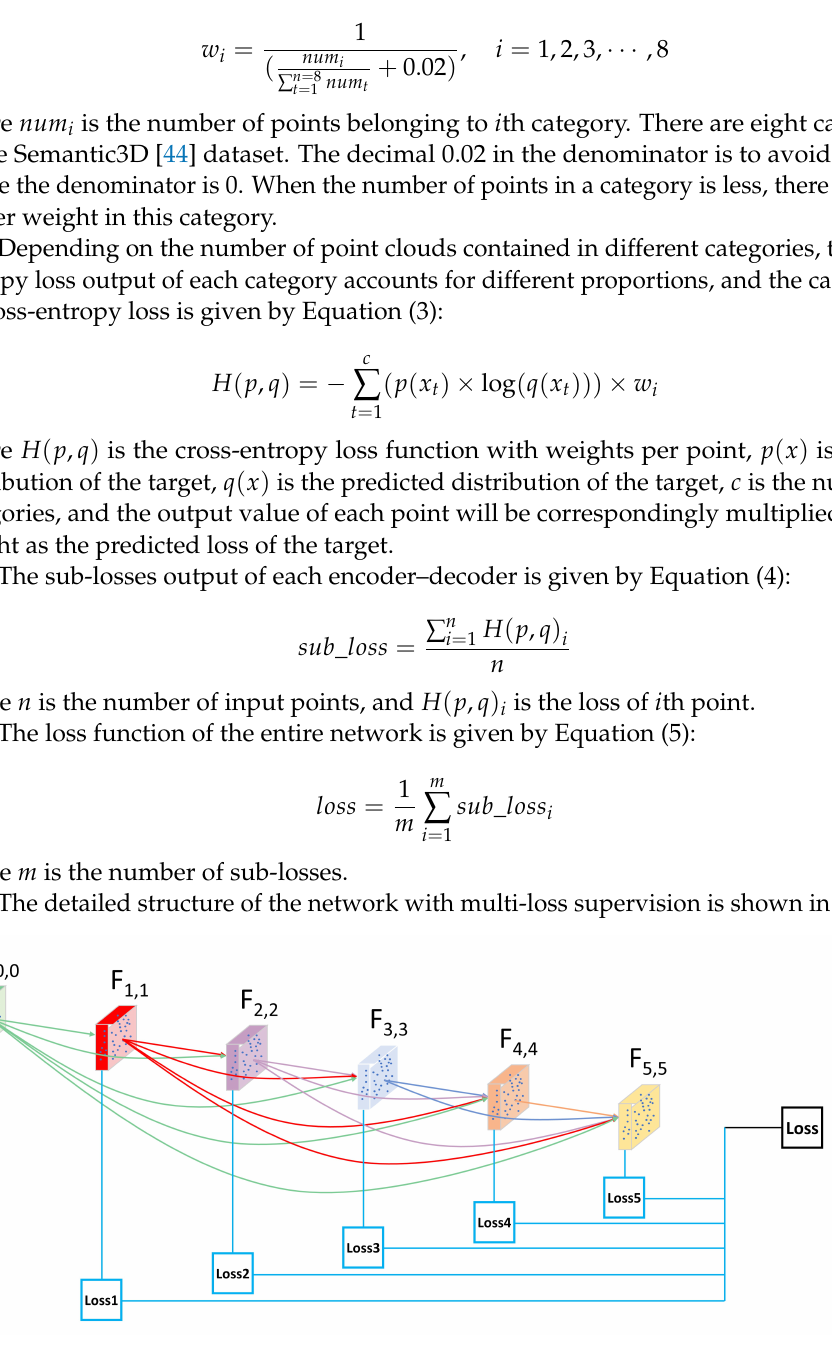
Figure 4. Multi-loss supervision module. The sub-losses are attached to the end of each decoder, which could control the training of the local structure of the network. The loss function of 6-layers MFFRand consists of five